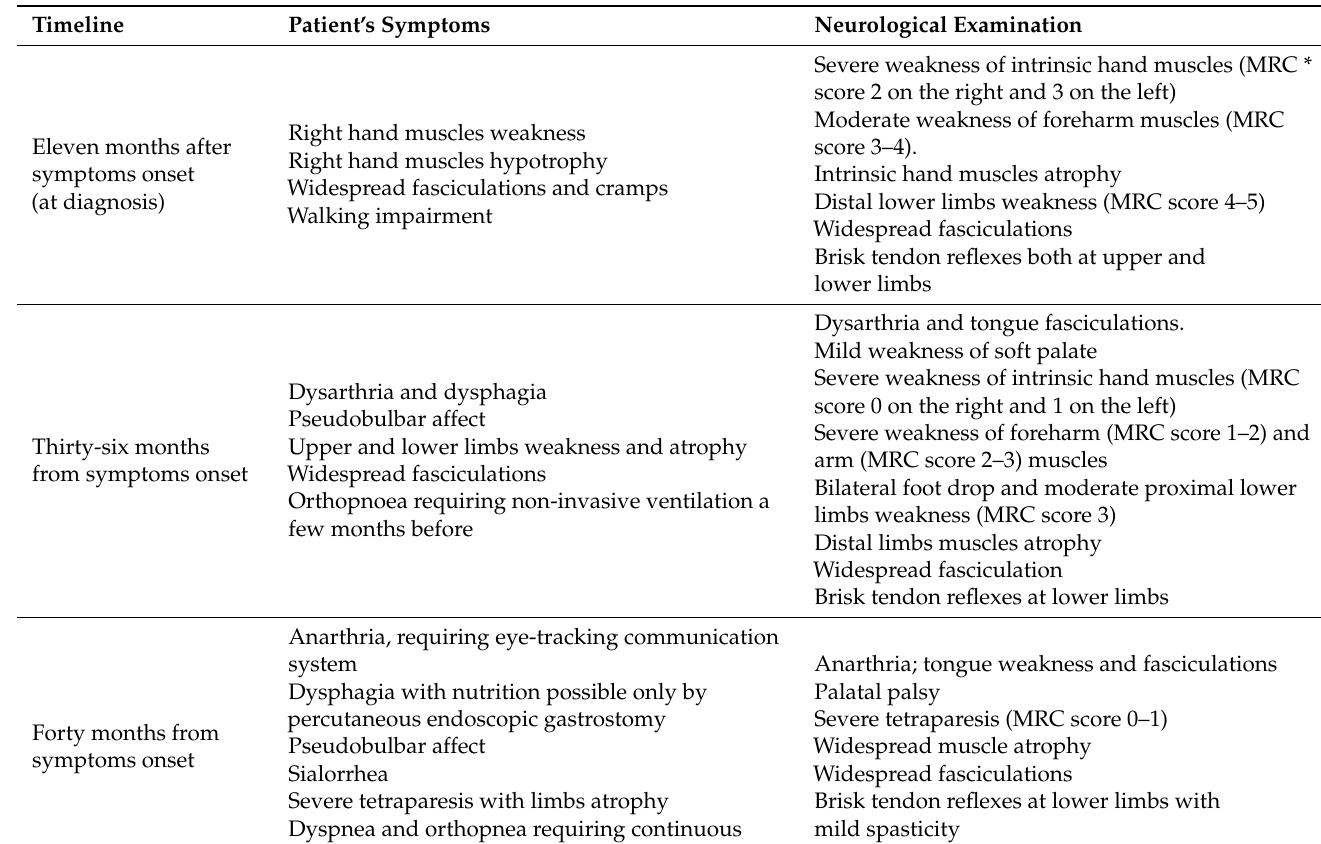
Figure 1. Family pedigree of the family with ALS patients carrying p.Ala382Thr mutation in TARDBP gene. The available DNA samples are indicated by asterisks (*); the proband (IV—2) is marked with an arrow. The filled symbols indicate the affected individuals, with black indicating ALS, grey indicating individuals with other neurological diseases. Table 1. Main patient’s symptoms and signs during disease course. * Medical Research Council’s (MRC) scale uses a score of 0 (no contraction) to 5 (normal power) to grade the power of a particular muscle